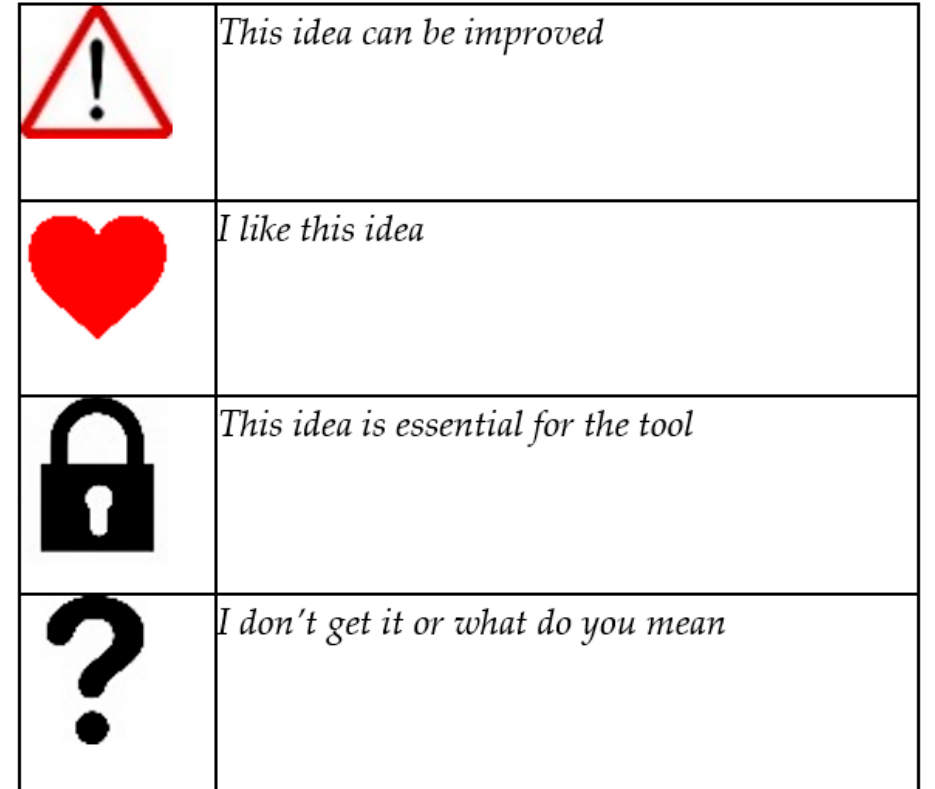
Figure 2. Stickers used by the expert panel.